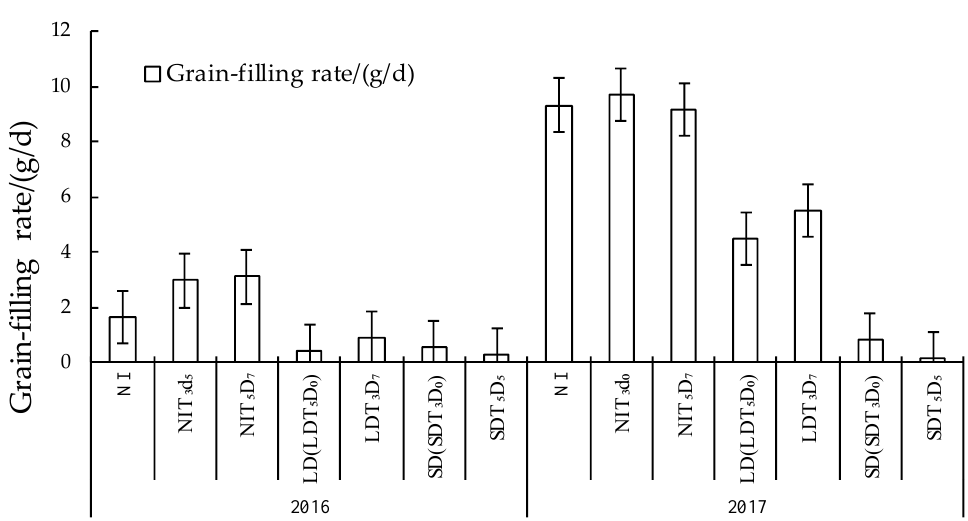
Figure 5. Response of grain filling rate to the interaction of high temperature and drought during the summer maize grout period.